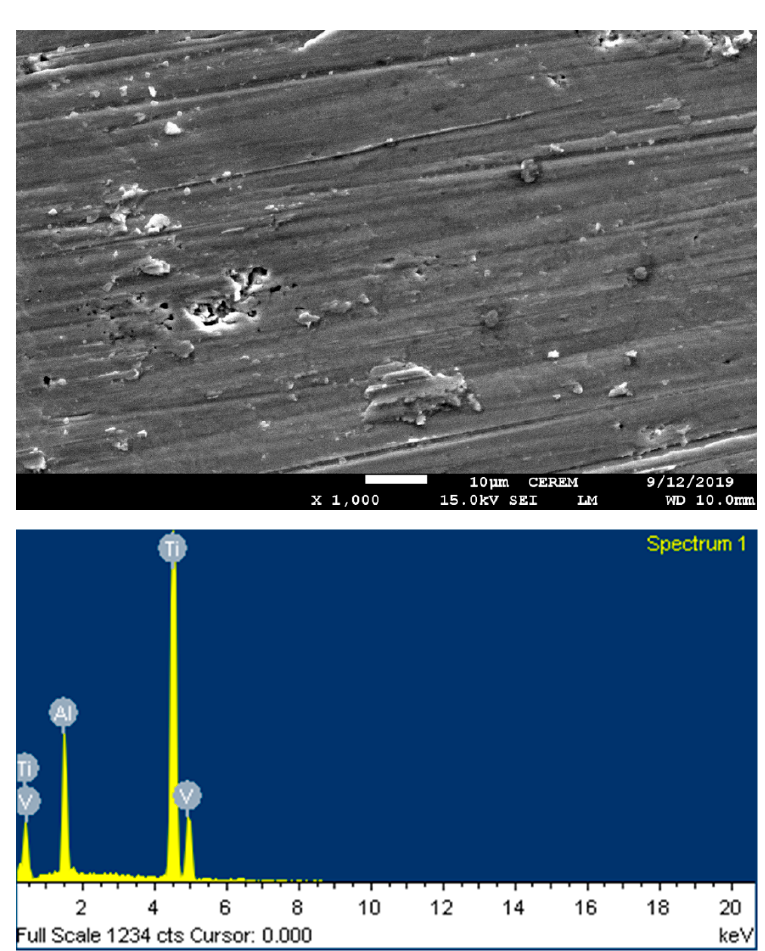
Figure 11. SEM micrograph and EDX spectrum obtained for Ti6Al2V alloy after its immersion for 48 h before stepping the potential to 300 mV (Ag/AgCl) for 40 min.